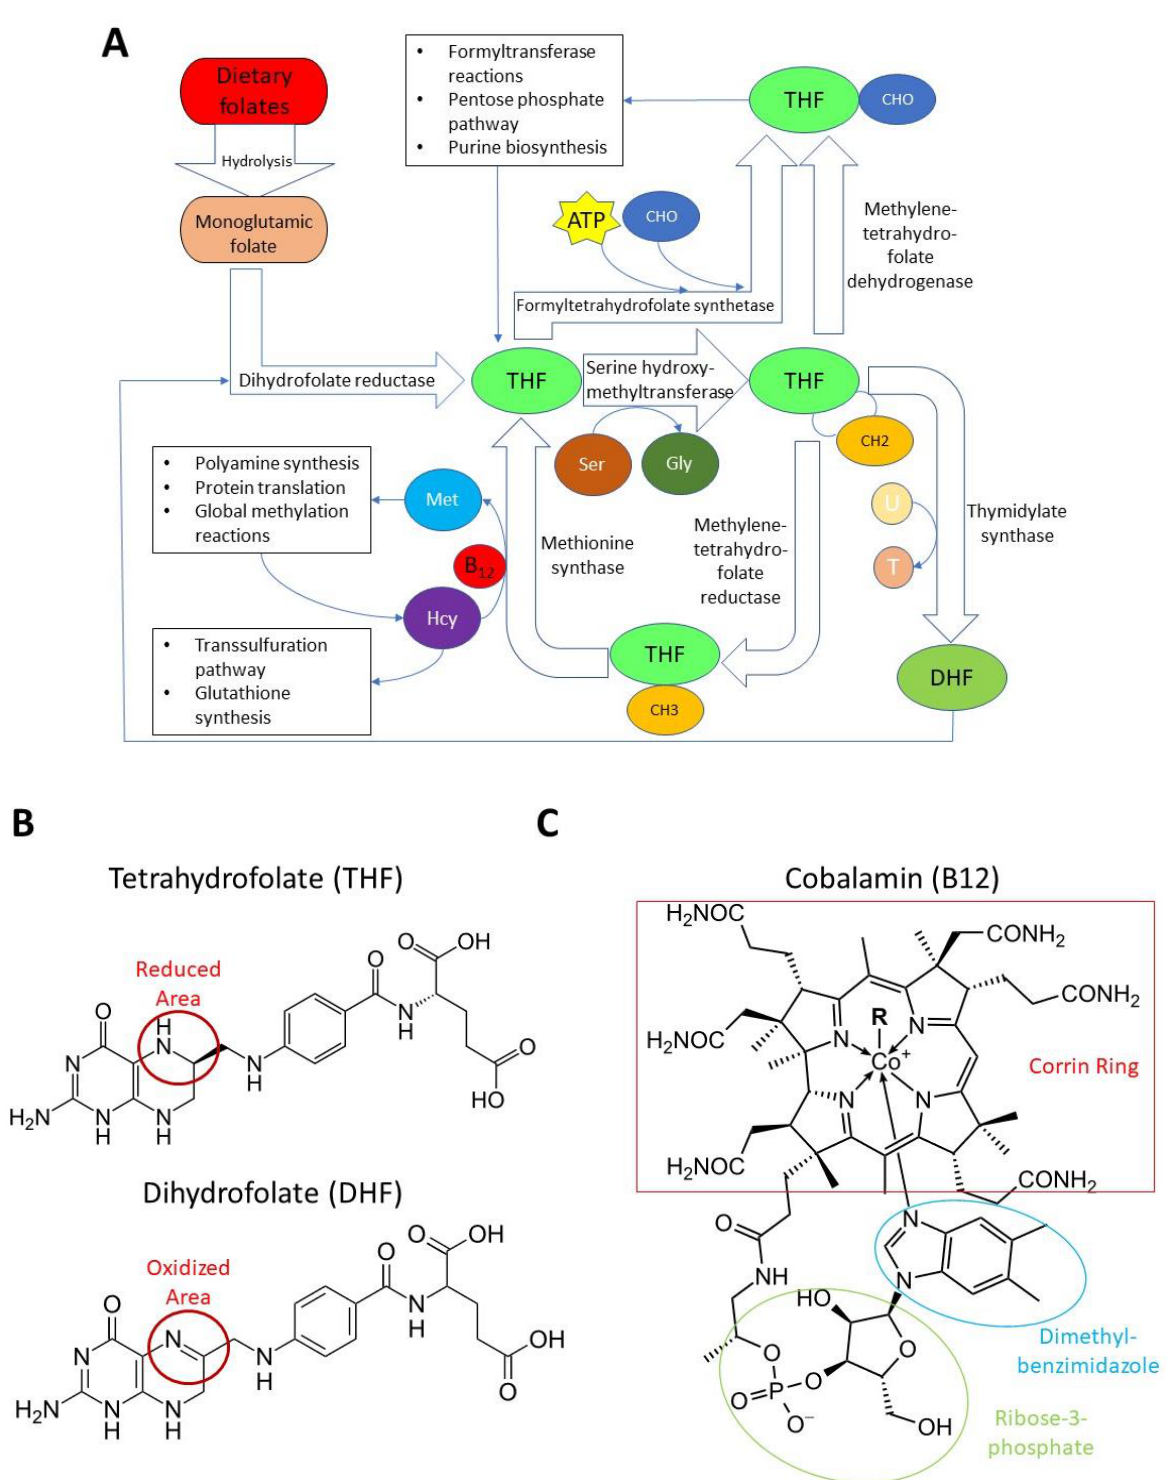
Figure 1. Outline of folate metabolism. Enzymatic processing of dietary folate to metabolically active cofactors and subsequent participation in single-carbon metabolism ( A ). Molecular structure of dihydrofolate DHF and tetrahydrofolate ( B ) as well as B12 ( C ). CHO: free formaldehyde or a formyl group. CH2: methylene group. CH3: methyl group. Met: methionine. Hcy: homocysteine. Ser: serine. Gly: glycine.